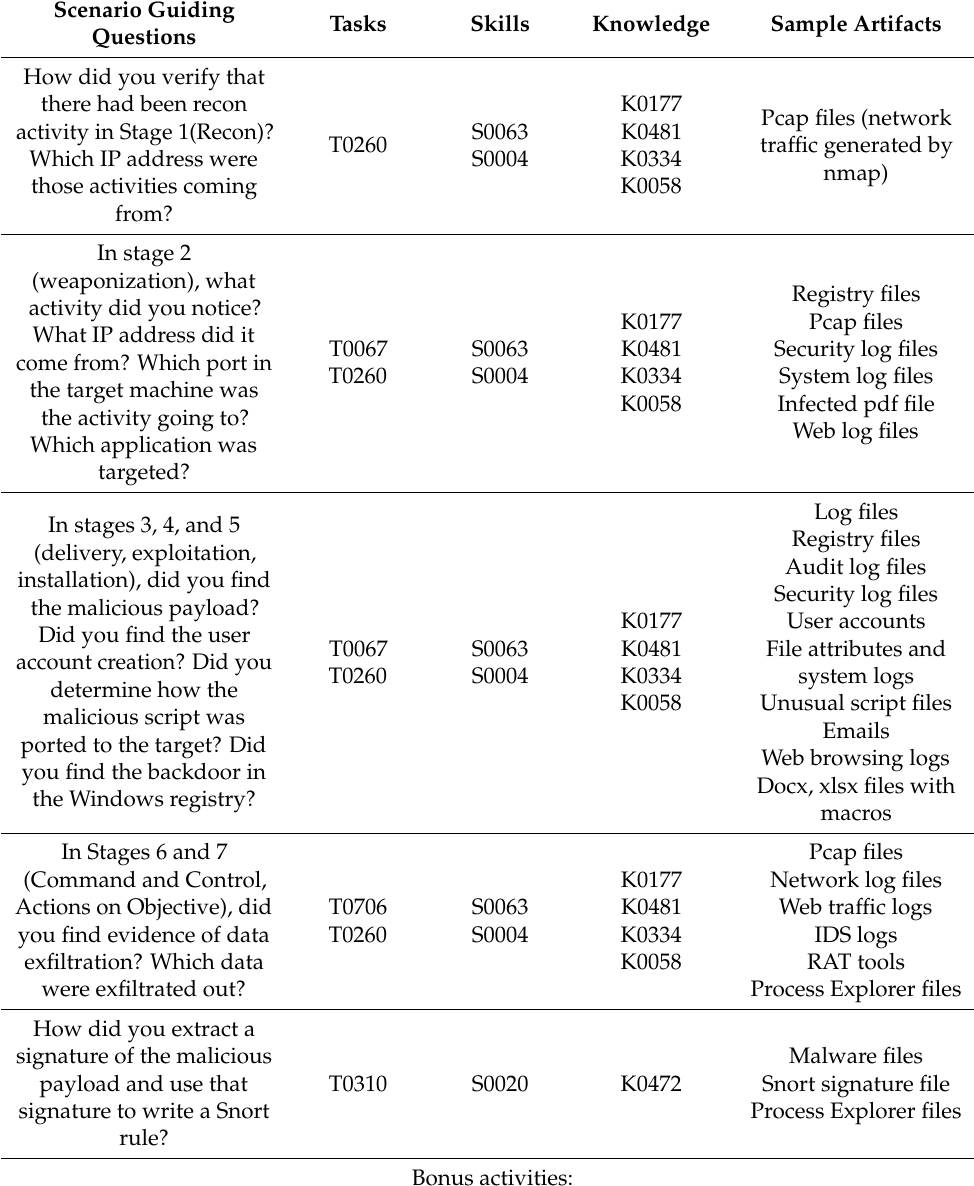
Table 2. Assessing KSTs and Competencies from Scenarios— Competency: Computer Network Defense